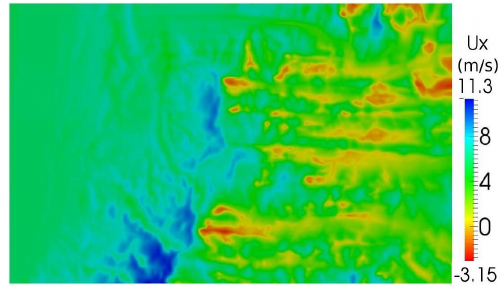
Figure 15. Wind speed in x -direction at 80